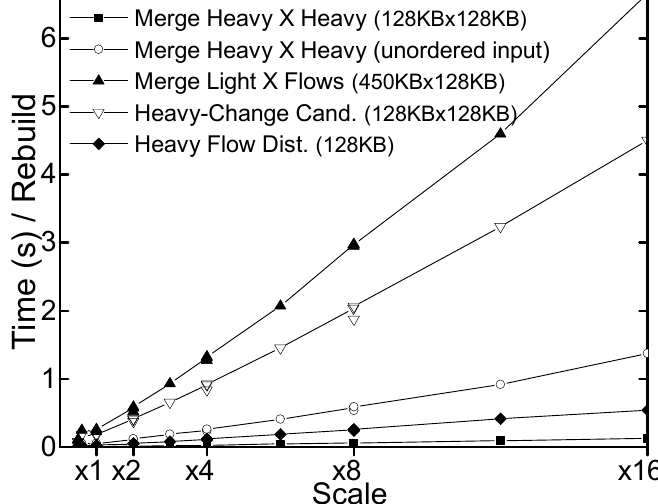
Figure 9. Input size vs. computation